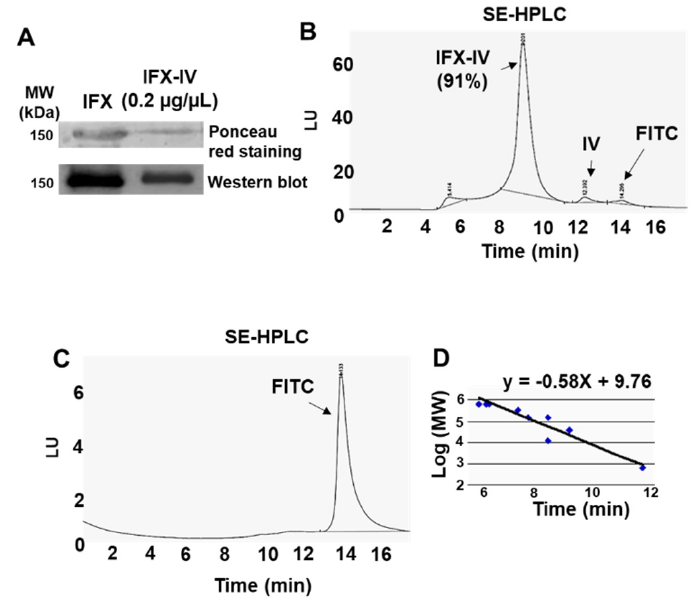
Figure 10. ( A )SephadexG25chromatographicprofilesofIFX-IVcomplexes. ( B )SE-HPLCchromatographic Figure 10. ( A ) Sephadex G25 chromatographic profiles of IFX-IV complexes. ( B ) SE-HPLC profile of IFX-IV complex obtained at the ratio 5:1. chromatographic profile of IFX-IV complex obtained at the ratio 5:1.